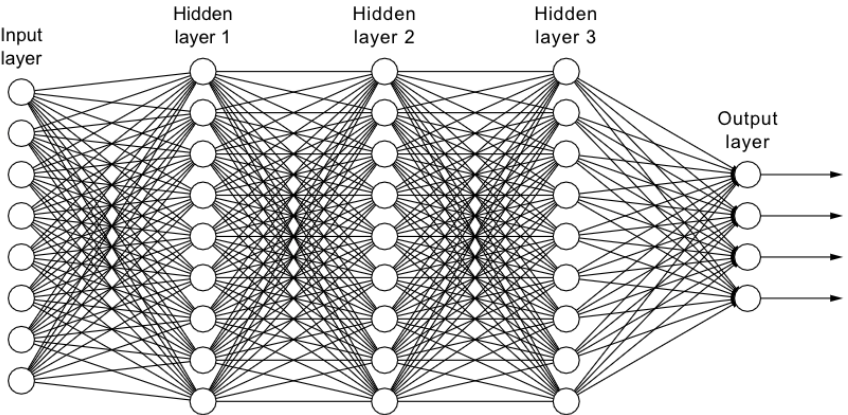
Figure 6. An example of a neural network with three hidden